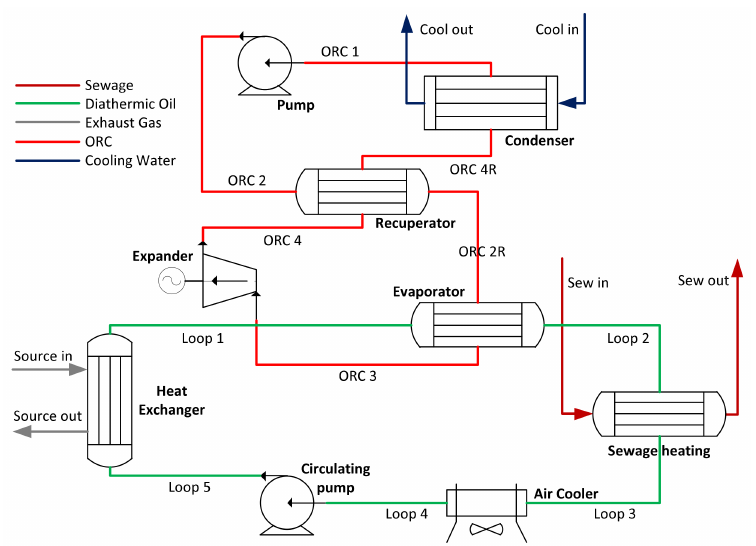
Figure 5. The subset of the biogas production plant that was modeled and